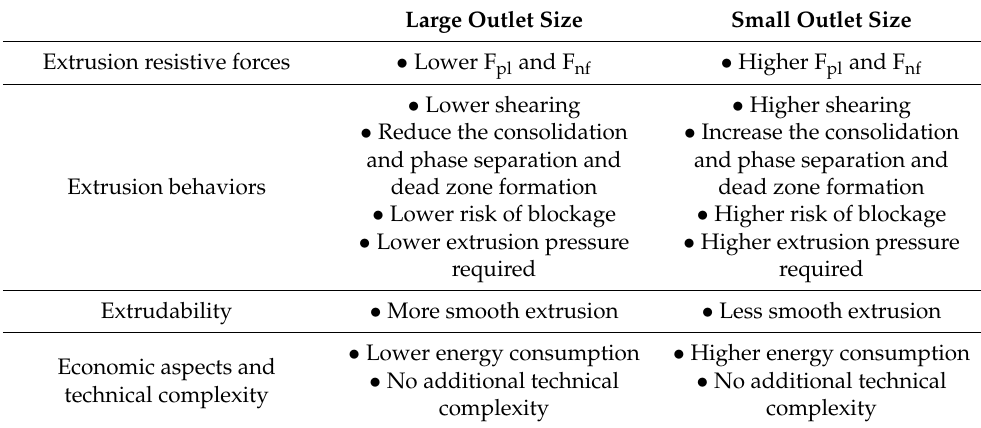
Table 6. The effects of outlet size on the extrusion forces, extrusion behaviors, extrudability and economic aspects and technical complexity based on the same material design and operational